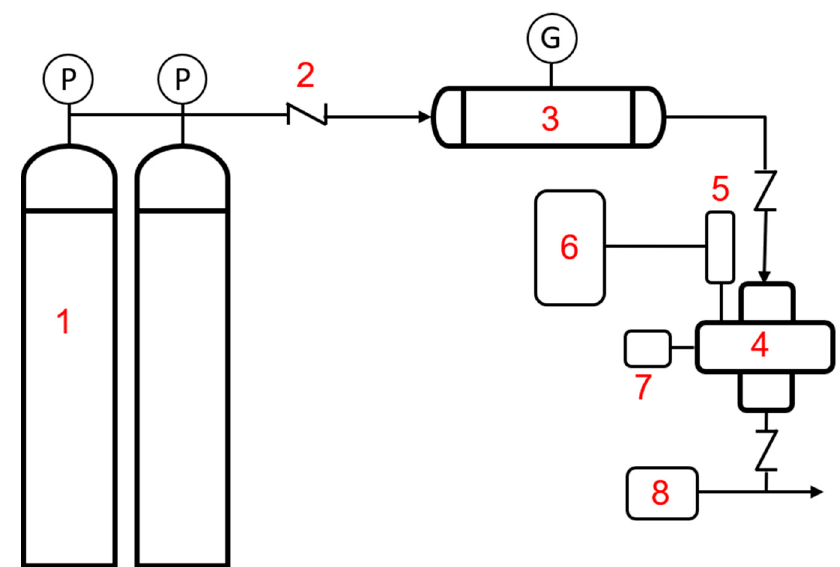
Figure 1. Schematic diagram of the volumetric set-up for CO 2 adsorption. 1 . Feed gas 2 . Check valve 3 . Loading column 4 . Adsorption column 5 . High pressure transducer 6 . Pressure meter 7 . Thermocouple 8 . Vacuum pump; P : pressure regulator; G : pressure gauge.